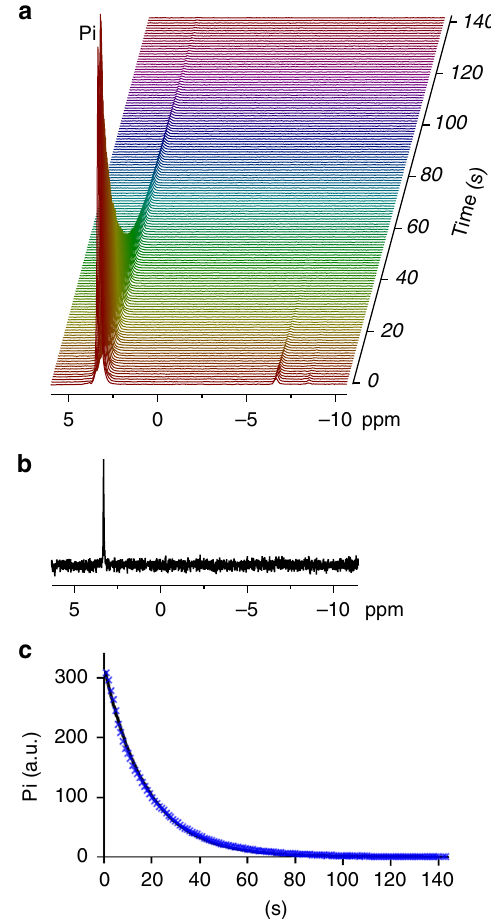
Fig. 2 High-resolution 31 P NMR spectra of Pi in a hyperpolarized state and at thermal equilibrium. a 31 P NMR spectra of hyperpolarized Pi in D 2 O (2.72 mM). The solid-state polarization was carried out in basic pH and the dissolution medium pH was 8.1 (with the Pi). The individual spectra, acquired with 1 s temporal resolution, are presented using a Maroon color scale for visual clarity and convenience. A total of 180 scans were acquired. Only the spectra with visible Pi signal are shown. The excitation angle was 10° at a fi eld of 5.8 T. The initial polarization demonstrated in the 1st spectrum was 9.6%. The line width of the hyperpolarized signals was 13 Hz. b A thermal equilibrium 31 P spectrum of the same sample shown in a , acquired with 400 excitations, a nutation angle of 90°, and a repetition time of 151 s ( ca . 17 h of acquisition). c The decay of the hyperpolarized Pi signal is demonstrated via the integrated intensity of the Pi signal (in arbitrary units, a.u.), marked with blue x. The fi t of the data to the longitudinal relaxation decay equation (see “ Methods ” ) is depicted by the continuous line ( black ). This fi t resulted in a T 1 of 24.2 s (95% con fi dence interval 23.7, 24.6